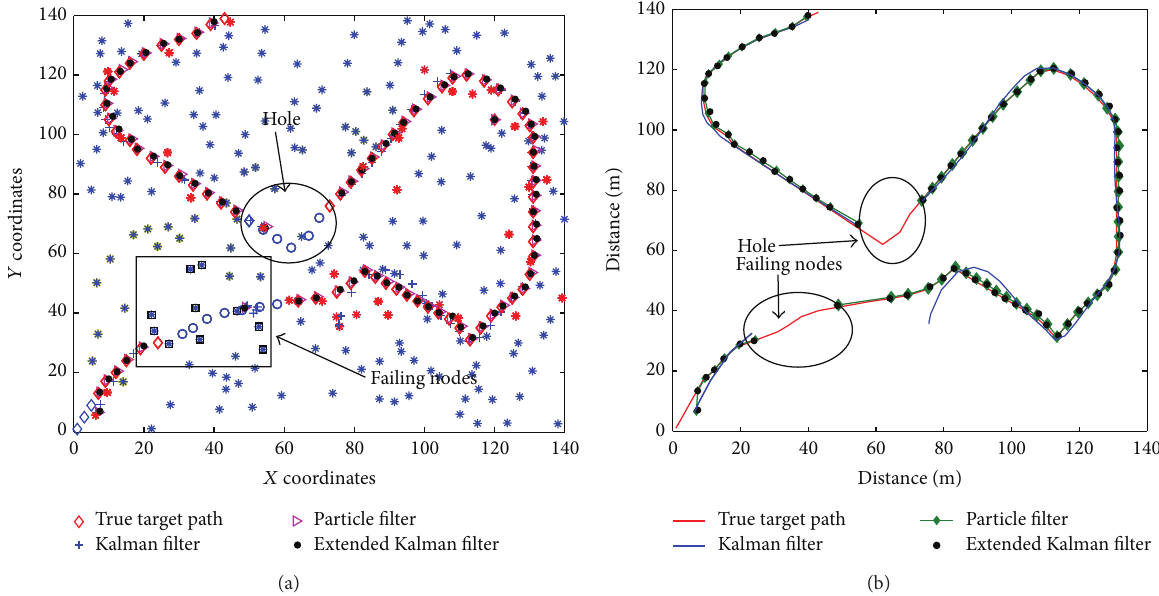
Figure 7: (a) Loss of target due to communication failure—Case II trajectory. (b) Loss of target due to communication failure—Case II graph.